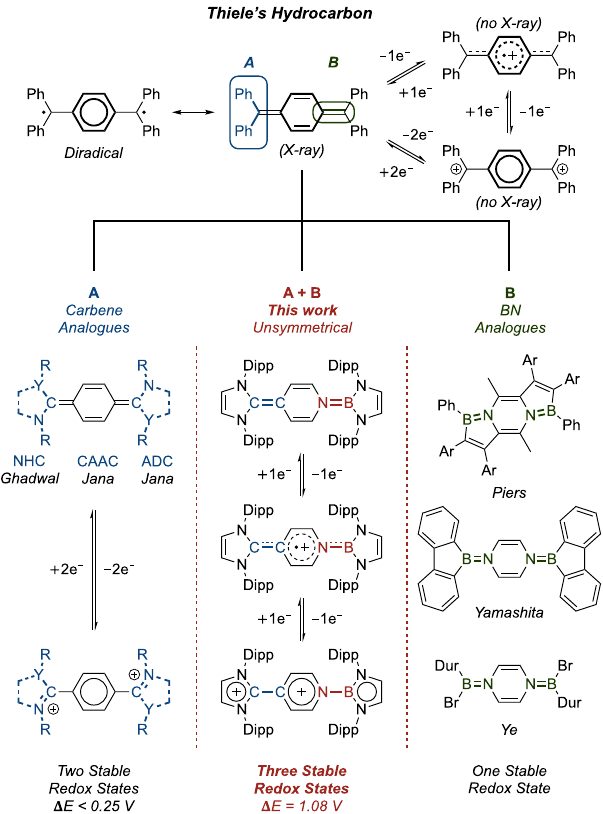
Fig. 1 Systems derived from Thiele ’ s hydrocarbon. Thiele ’ s hydrocarbon, its radical cation and dication; previous modi fi cation methods A , B and present work. (Dipp = 2,6-diisopropylphenyl, NHC = N-heterocyclic carbene, CAAC = cyclic (alkyl)aminocarbene, ADC = acyclic